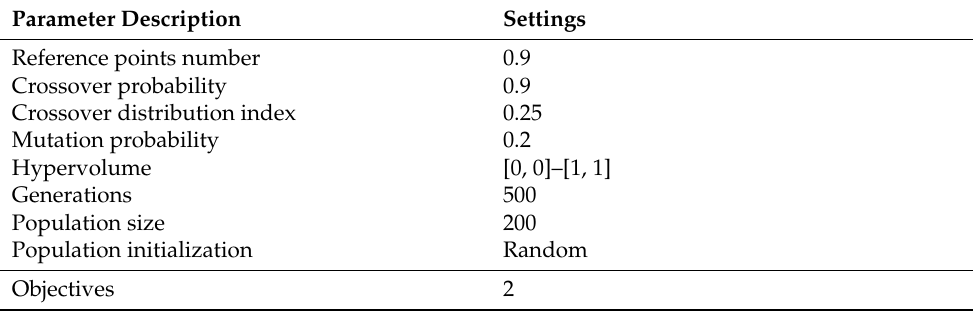
Table 1. NSGA family parameter setting.